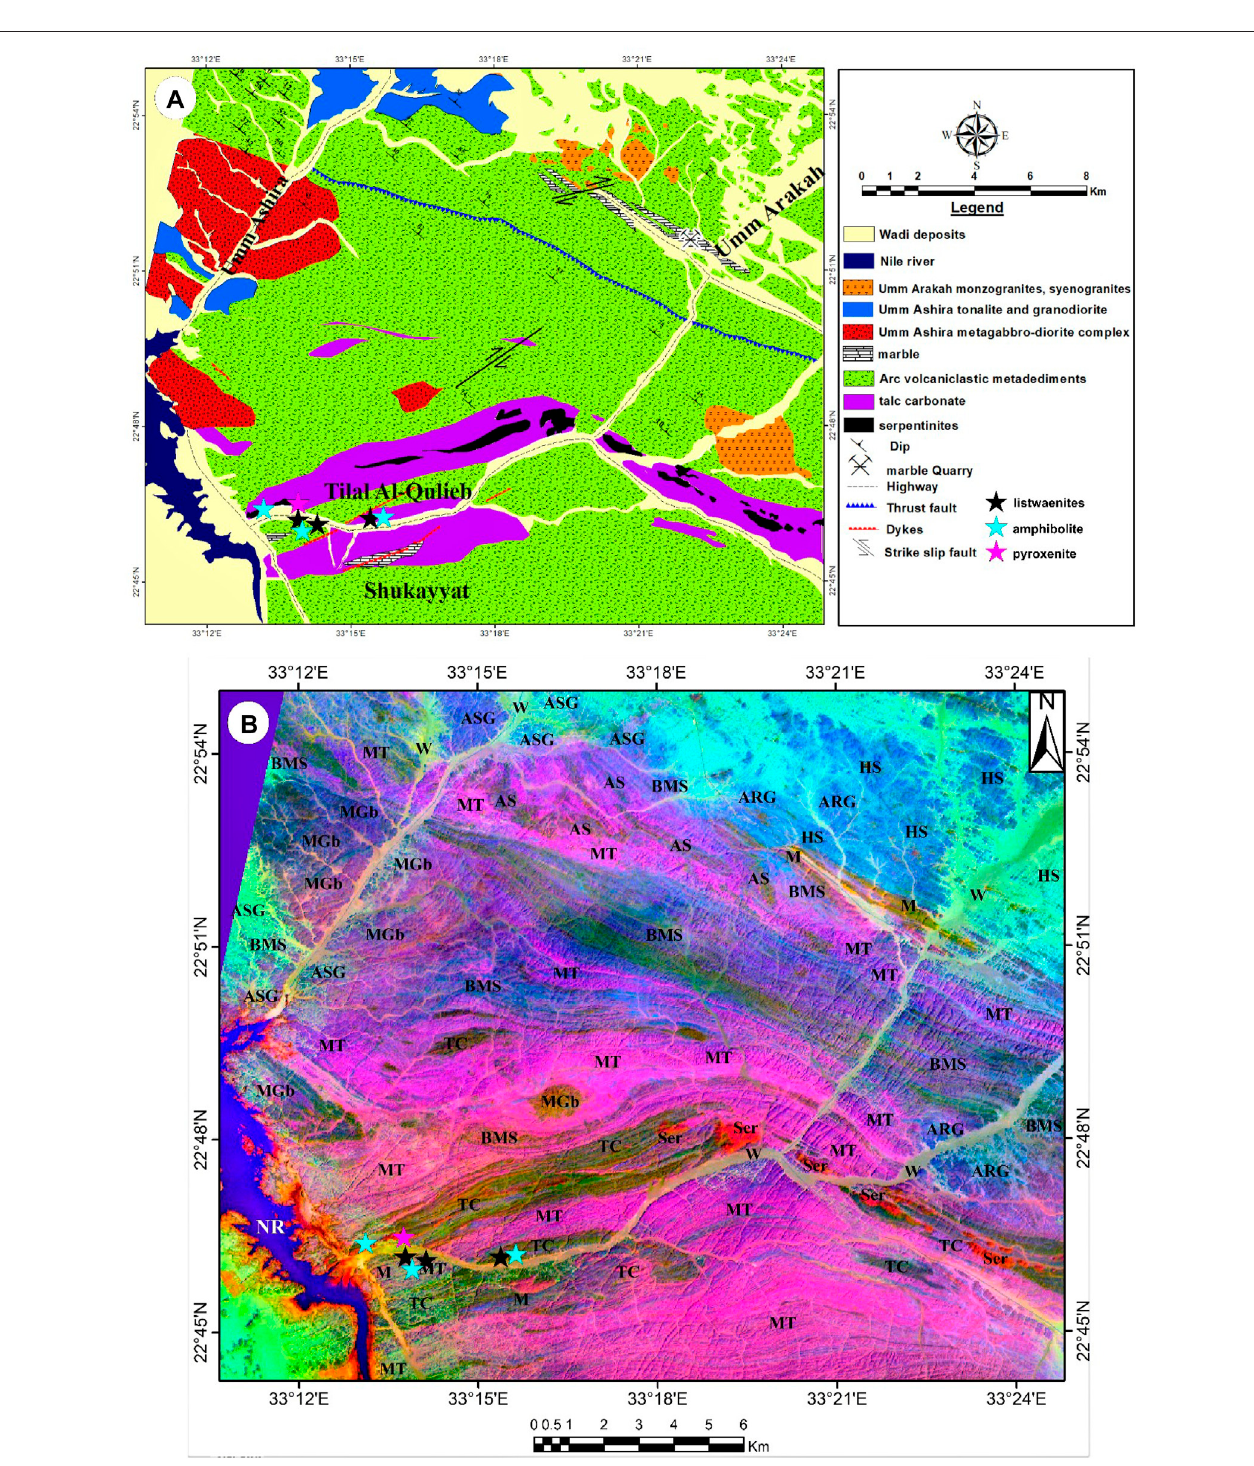
FIGURE2|(A) Geologic mapofWadi TilalAl-Qulieb and WadiUm Ashiraareasmodi fi edafter Noweir et al.(2000). (B) Location mapofthestudied areaaccording to the PCA (PC3, PC1, and PC4 in RGB) image. Abbreviation: ARG, Umm Arka granites; AS, actinolite schist; ASG, Umm Ashira granite; BMS, biotite and muscovite schist; HS, hornblende schist; M, marble; MGb, metagabbro; MT, metamudstones and metatuffs; NR, Nile River; Ser, serpentinite; TC, talc-carbonate and W, Wadi deposits.